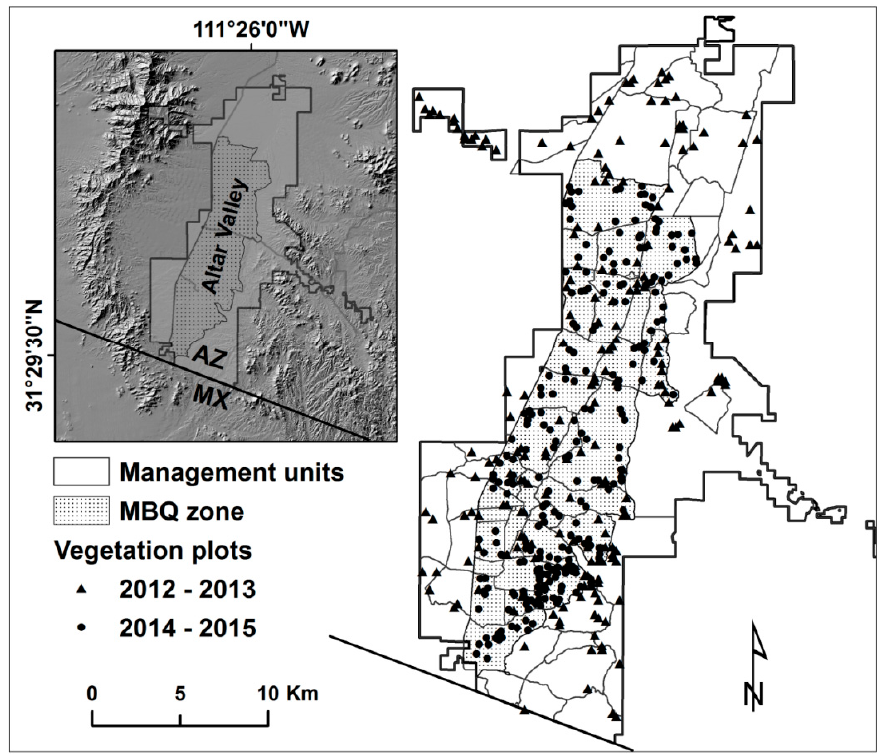
Figure 2. Study area on the US Fish and Wildlife Service, Buenos Aires National Wildlife Refuge in southern Arizona. Plots measured in 2012 and 2013 recorded plant species along point intercept transects. Destructive biomass measurements took place on a subset of plots ( n = 20) and quadrats ( n = 431) in 2013 to develop non-destructive fine-fuel biomass models. Plots measured in 2014 and 2015 added non-destructive quadrat measurements to vegetation transects for estimating fine-fuel biomass. The stippled area shown is the endangered masked bobwhite quail (MBQ) management zone. Climate is semiarid with low precipitation and humidity and high summer